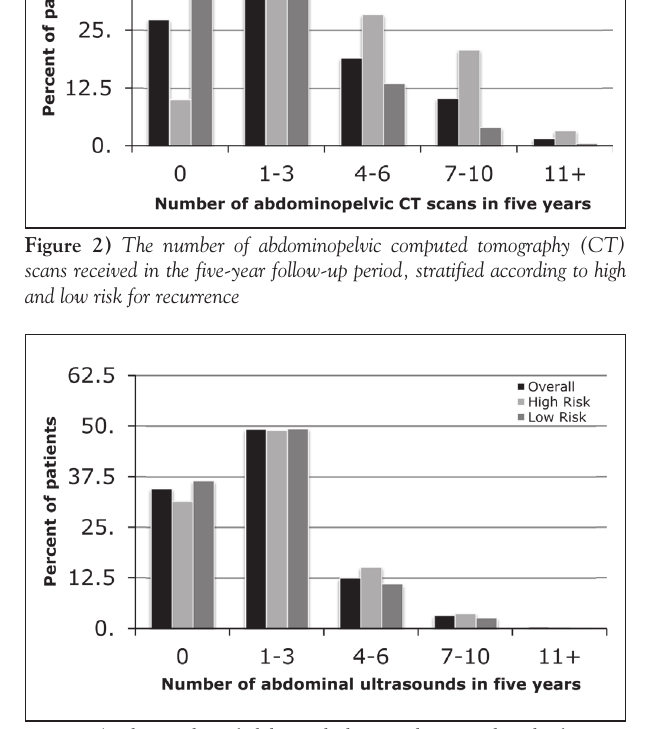
Figure 3) The number of abdominal ultrasounds received in the five-year follow-up period, stratified according to high and low risk for recurrence